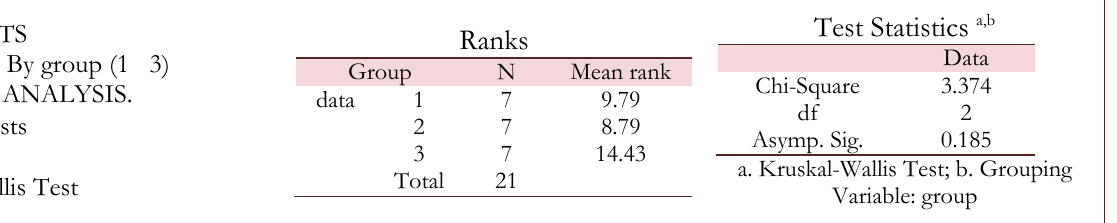
Table 6: Results of statistical